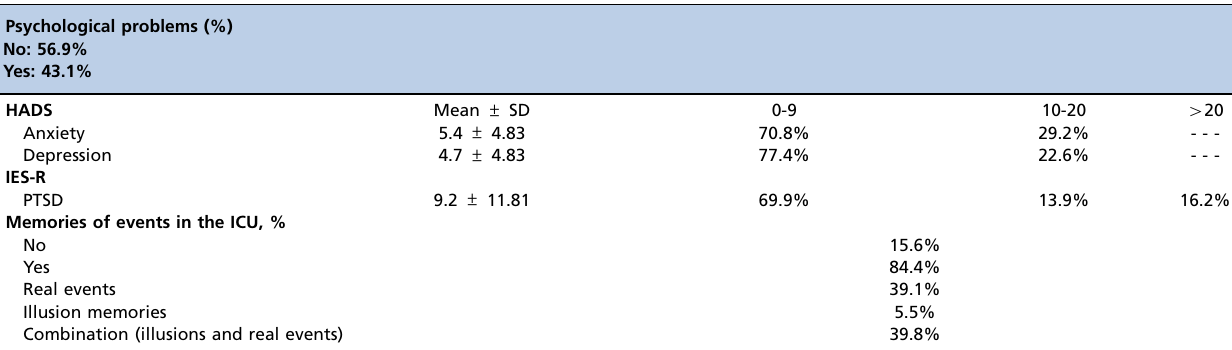
Table 3 - Psychological evaluation at the Post-ICU Outpatient Clinic